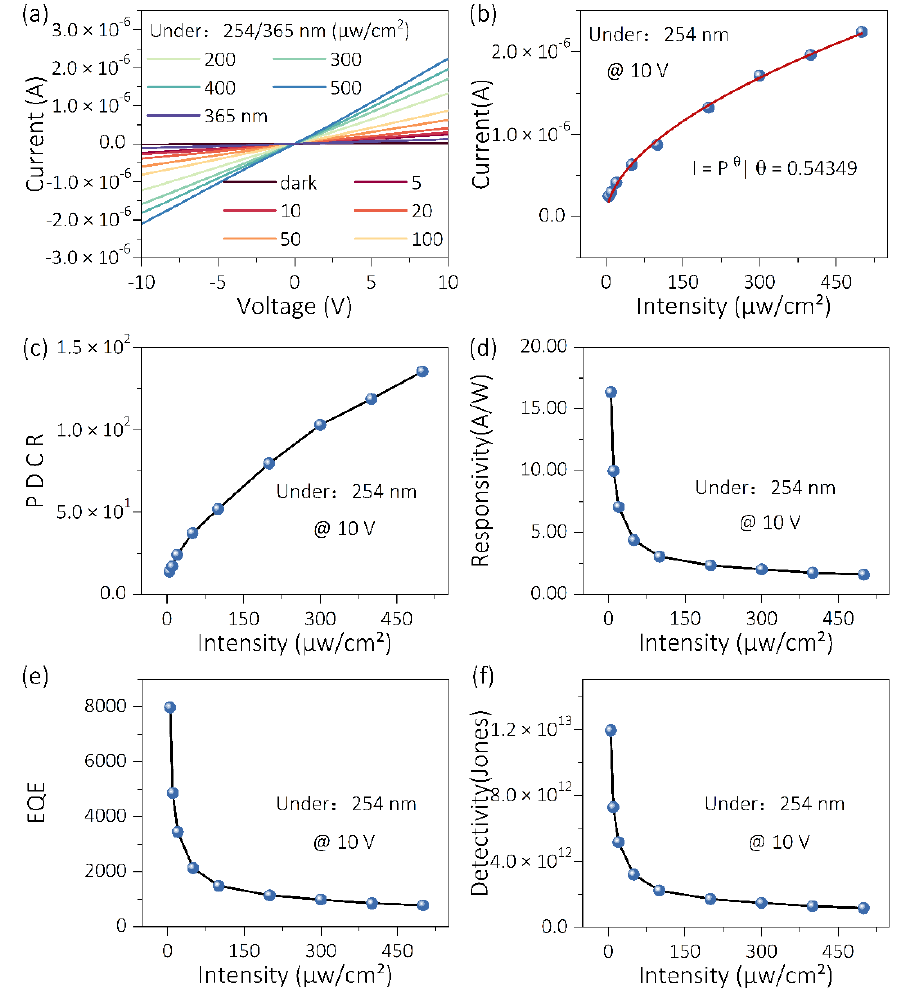
Figure 2. ( a ) I-V characteristic curves of a-Ga 2 O 3 thin film-based solar-blind ultraviolet photodetector at 10 V; and plots of ( b ) photocurrent and fitting curve; ( c ) light-to-dark current ratio; ( d ) responsivity; ( e ) EQE and ( f ) detectivity versus light intensity.